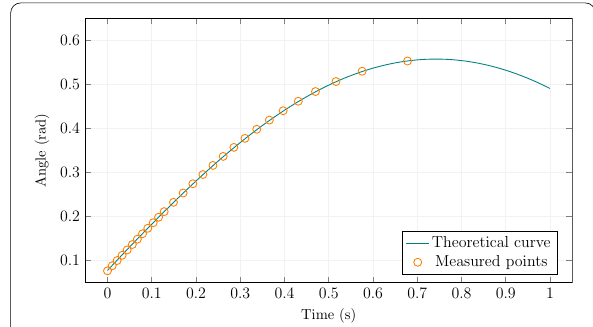
Fig. 10 The processed tracking of the specimen and fitted theoretical curve.